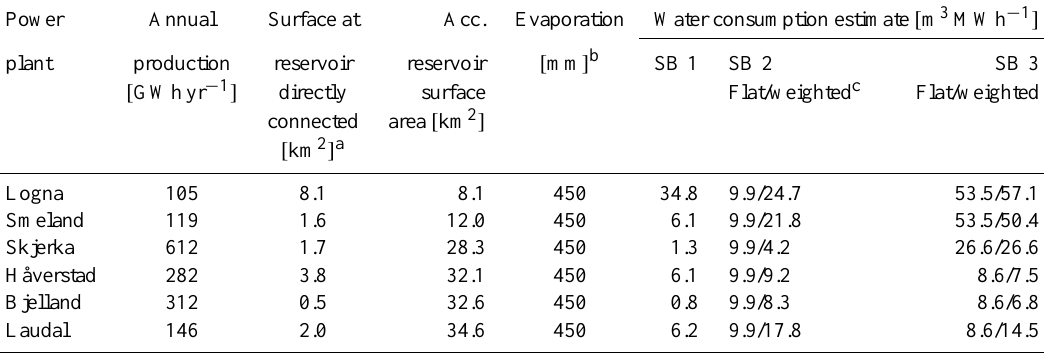
Table 2. Power plants, annual production and corresponding water consumption estimates for three different approaches for setting the spatial system boundaries for the cascaded regulation in Mandal River basin. The estimates given in the three columns to the right refer to flat and weighted (with respect to power production) water consumption numbers, respectively. Data sources: Agder Energi (2013), NVE Atlas (2013) and Beldring et al. (2002).